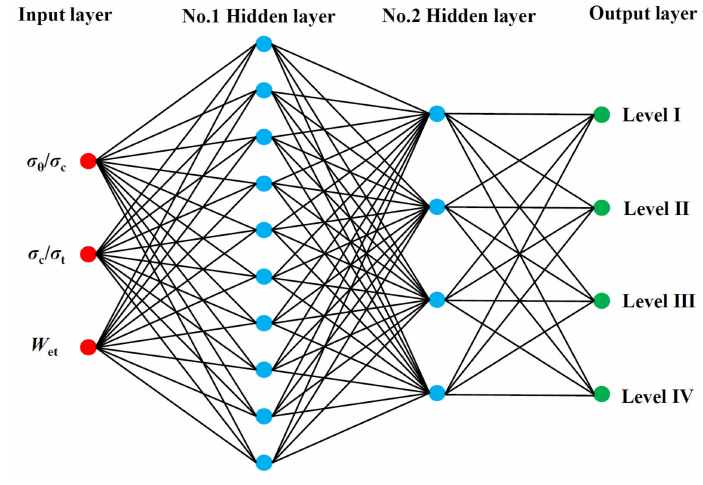
Figure 1. Structure of the BP neural